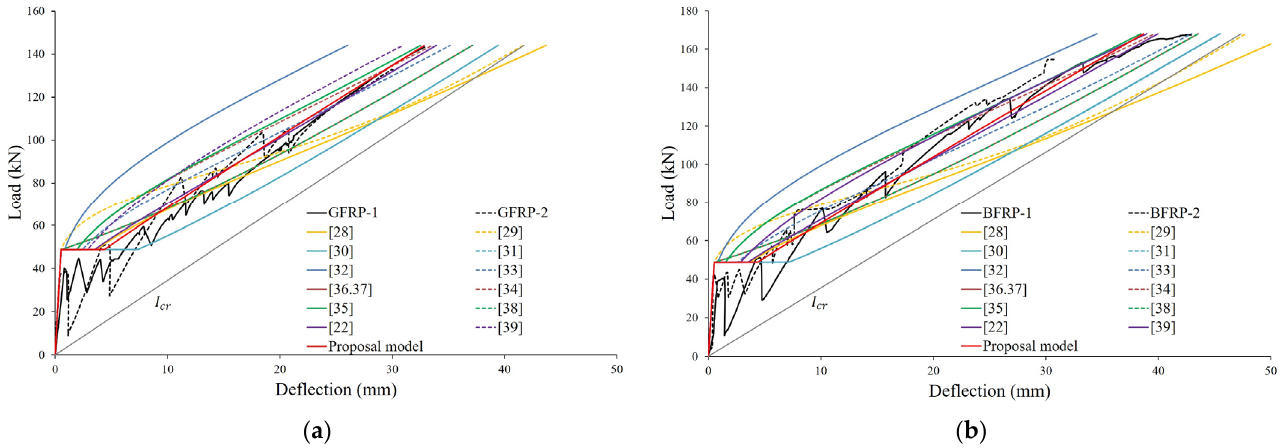
Figure 6. Comparison of analytical load–midspan deflection of FRP-reinforced concrete specimens: ( a ) GFRP-reinforced concrete specimens; ( b ) BFRP-reinforced concrete specimens.